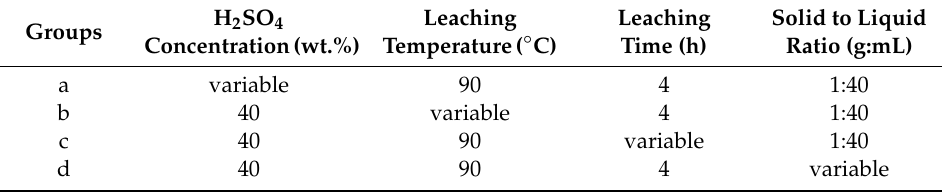
Table 2. The experimental parameters in the leaching of the pyrite and its roasted product. H 2 SO 4 Groups